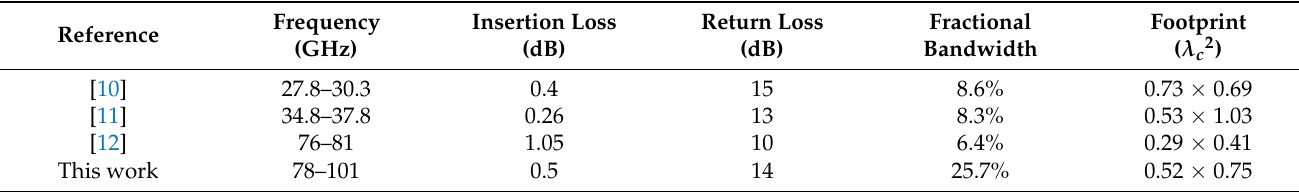
Figure 7. Simulated and measured results of two back-to-back transitions with an (a) LWG length of L 1 and (b) an LWG length of L 2 . Table 2. Comparison with previous LTCC LWG-to-RWG